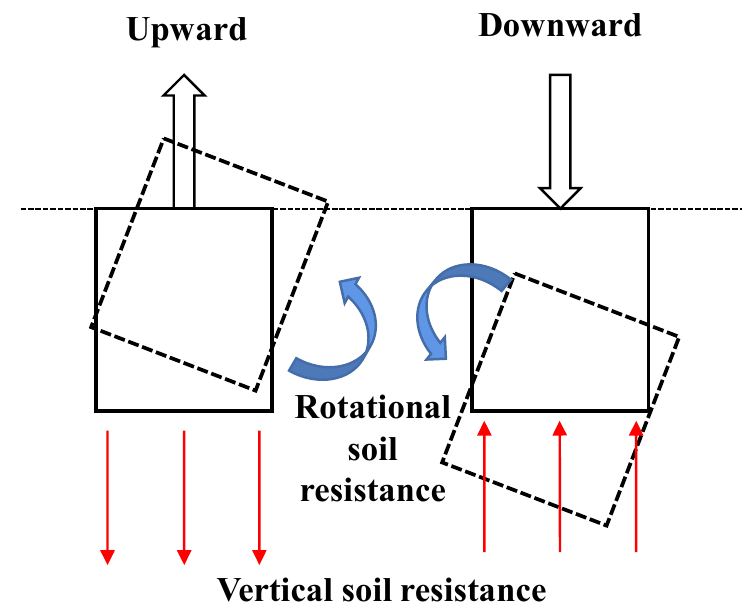
Figure 18. Principle of the soil resistances for tripod foundations under overturning moment.